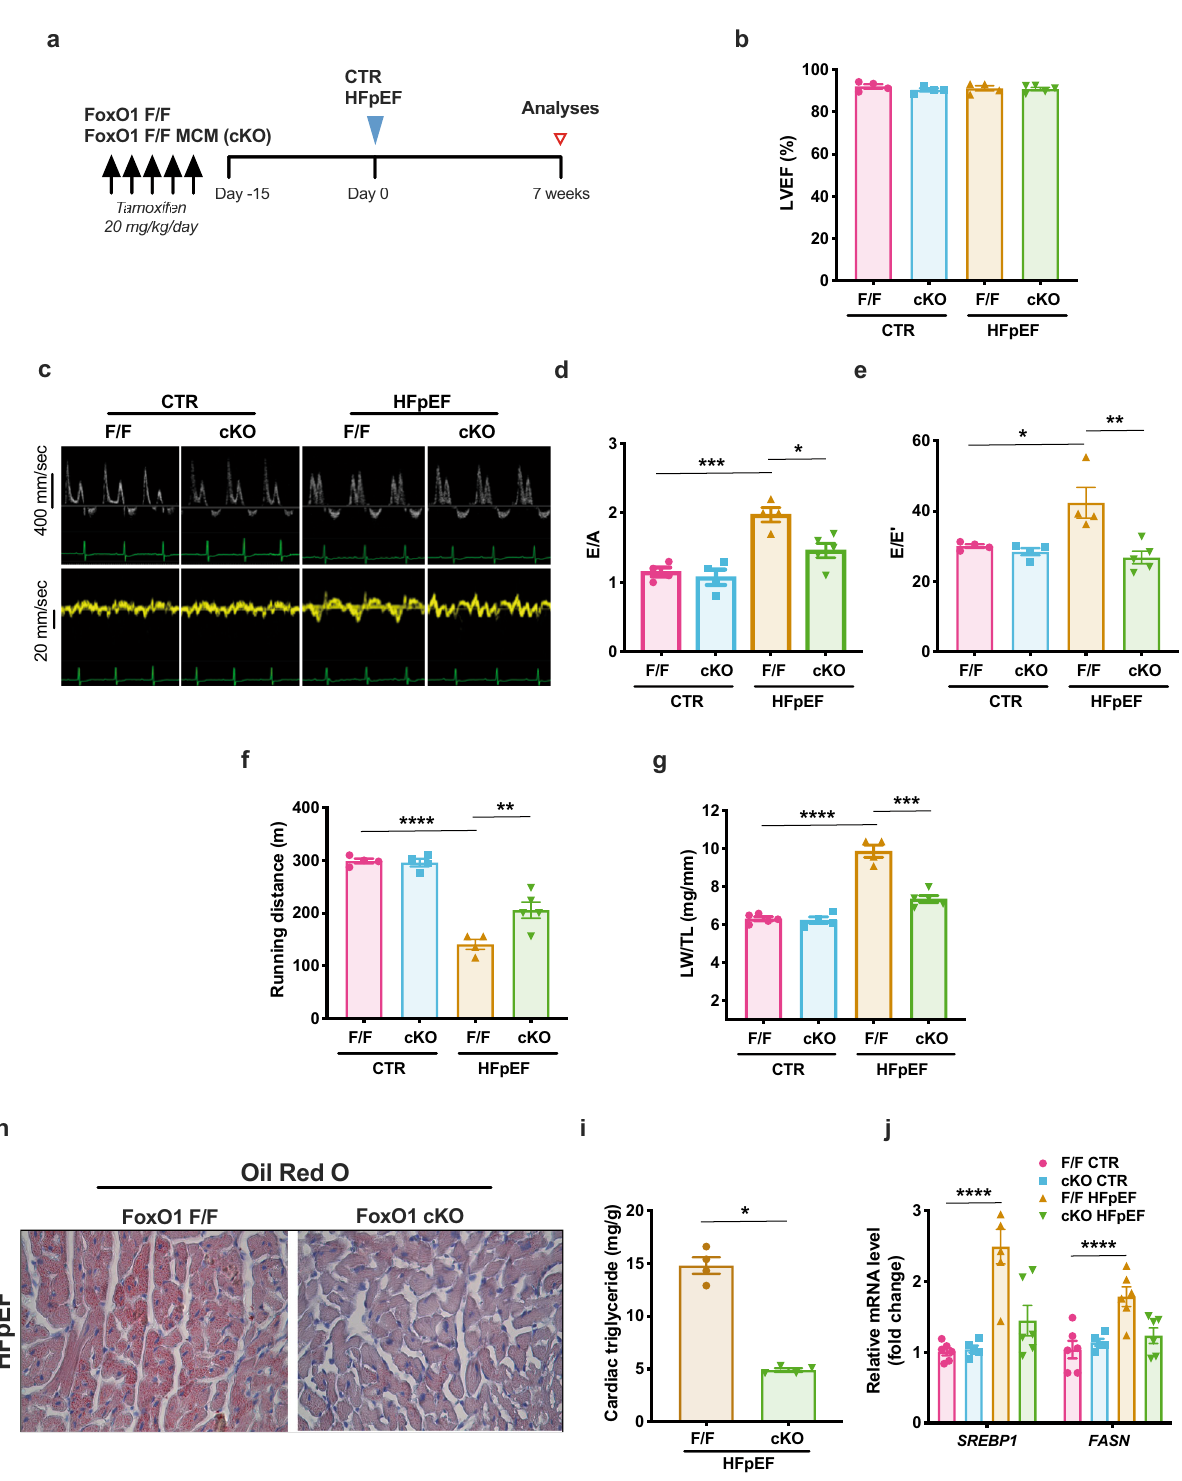
of HFD feeding in which Xbp1s is induced, STUB1 levels also increase (Supplementary Fig. 7d) Collectively, these data provide compelling evidence that STUB1 is a direct transcriptional target of Xbp1s. STUB1 regulates FoxO1 stability in cardiomyocytes . Our data suggest that Xbp1s activates STUB1 transcription, promoting the